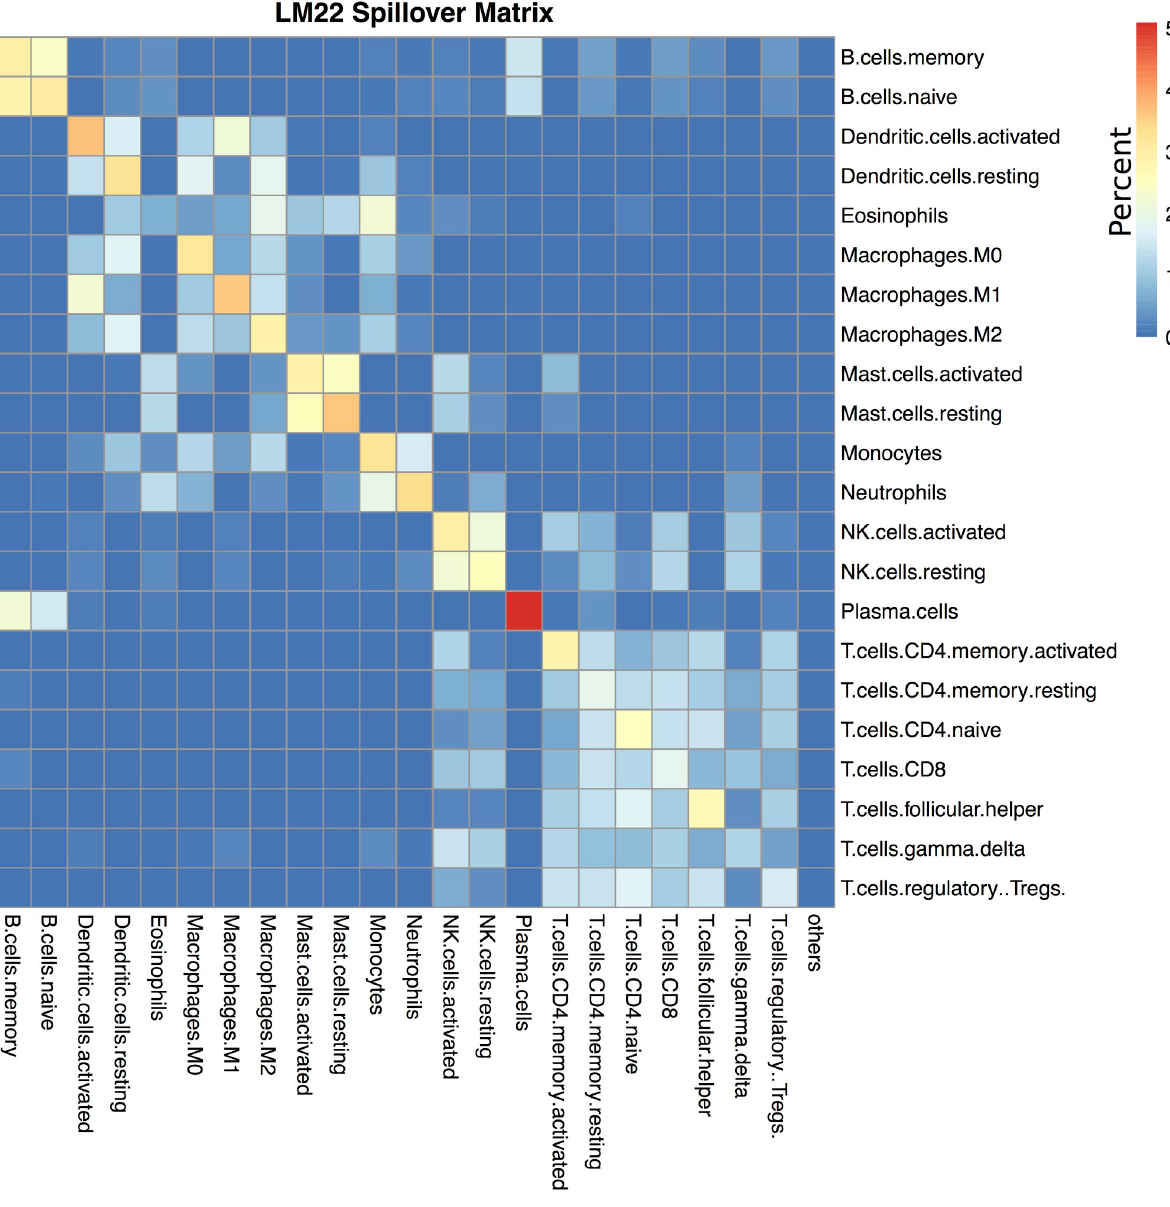
Fig 3. LM22 spillover matrix. Spillover matrix showing mean misclassification of purified samples for LM22. Rows show purified cell types and columns show what those samples deconvolve as. Cells are colored by percentage, such that each row adds up to 100%. For example, if the row is ‘B.cell. memory’, the column is ‘Plasma.cells’, then the color is light blue indicating that purified ‘B.cell.memory’ samples deconvolve as containing (on average) 18%